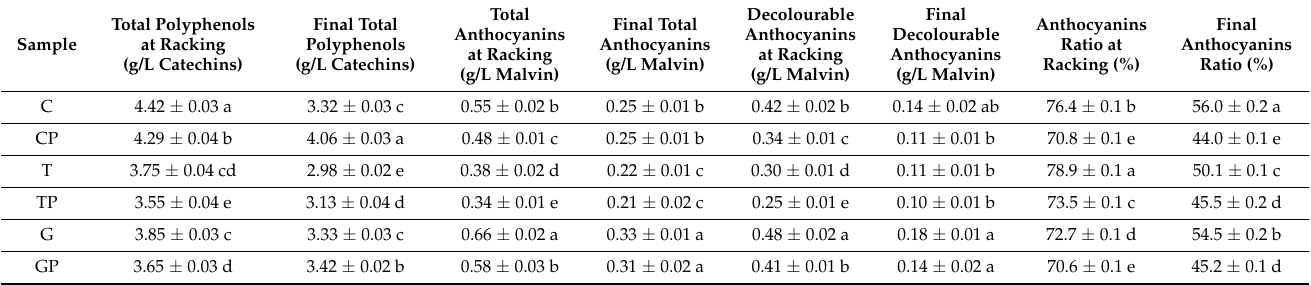
Chemical parameters at